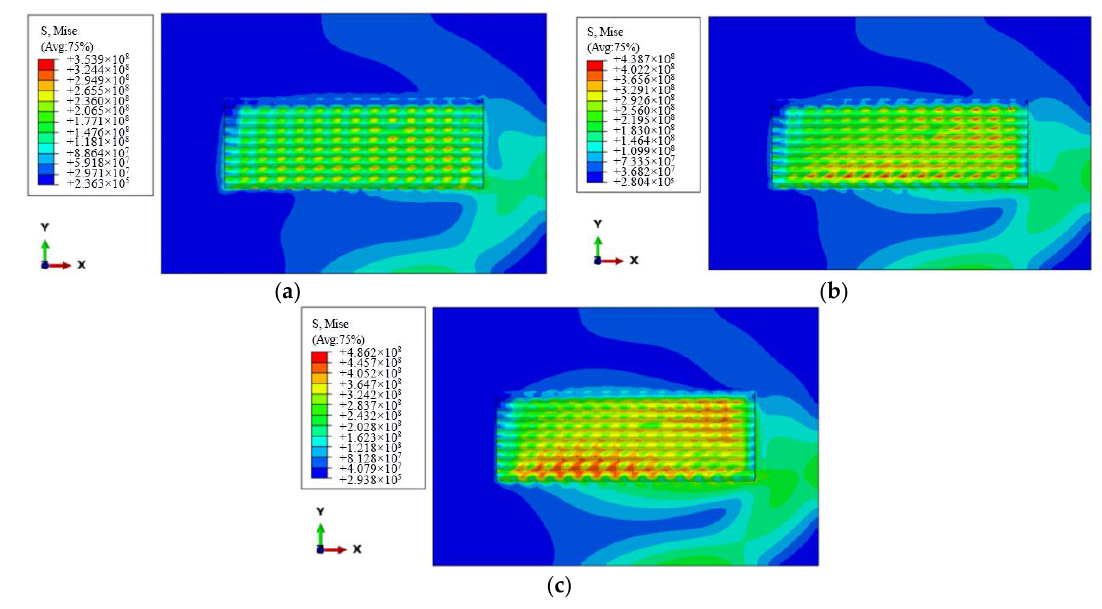
Figure 5. Influence nephogram distribution of working current on stress field: ( a ) working current 90 A; ( b ) working current 95 A; ( c ) working current 100 A.